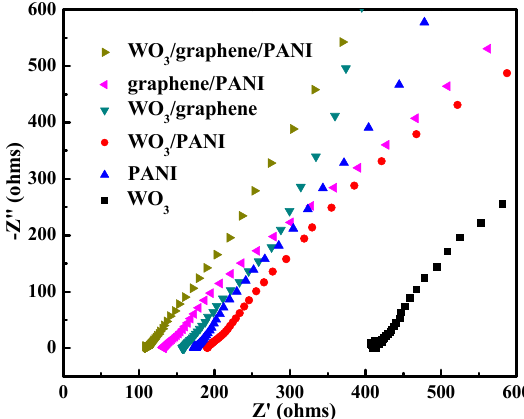
Figure 8. Nyquist plots of bare WO 3 , WO 3 / graphene, pristine PANI, WO 3 / PANI, graphene / PANI, and WO 3 / graphene / PANI films in 0.5 M H 2 SO 4 aqueous solution, respectively.